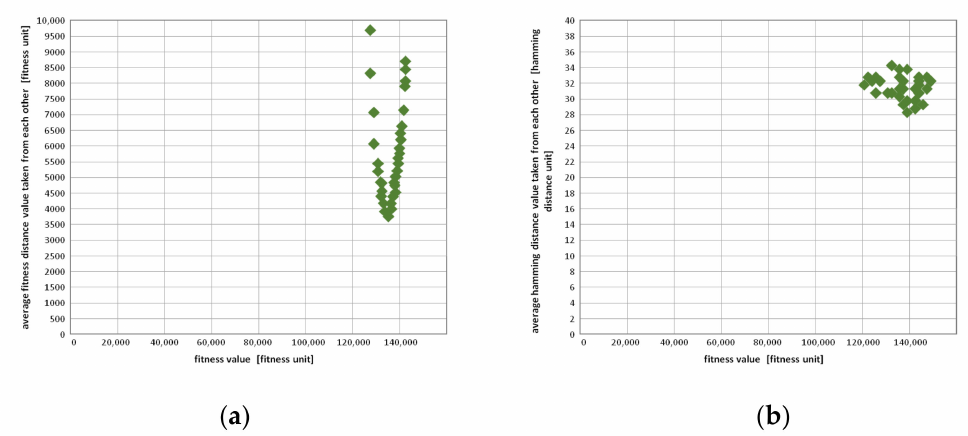
Figure 8. The fitness values and their average fitness distances ( a ) and the average hamming distances ( b ) from each other in case of 2-opt operator.